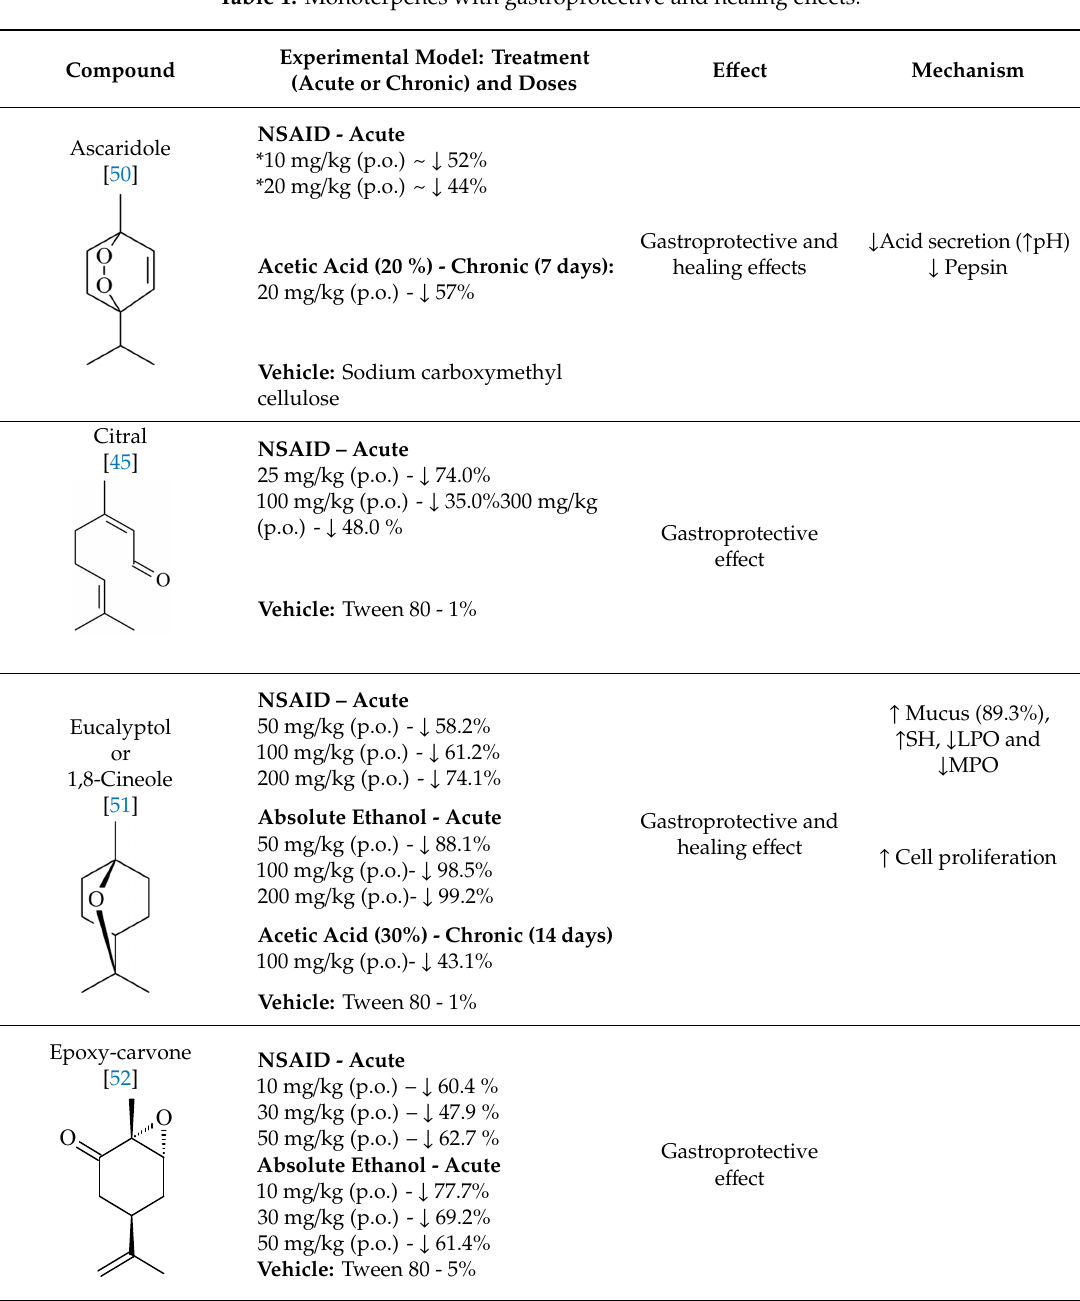
Table 1. Monoterpenes with gastroprotective and healing effects.